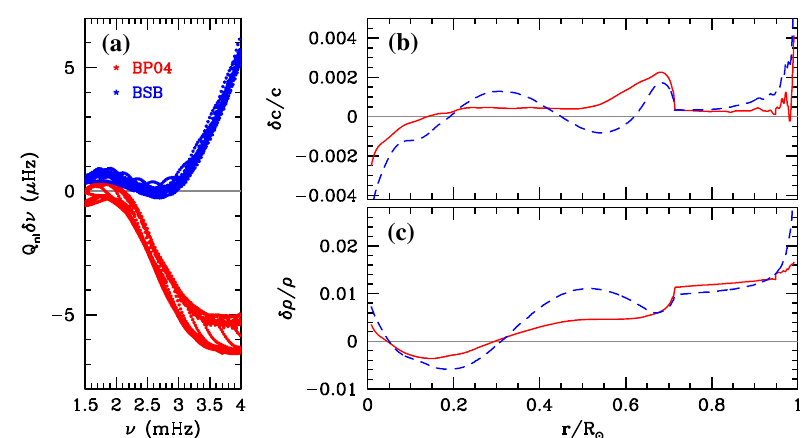
Fig. 7 a The scaled frequency differences between Model S and two other solar models. b The relative sound-speed differences, and c the relative density differences between the same models. All differences are in the sense (Model S–other